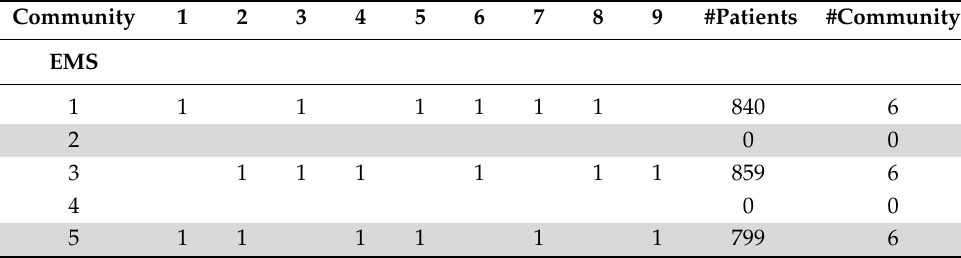
Table 5. Results of the decoding method.